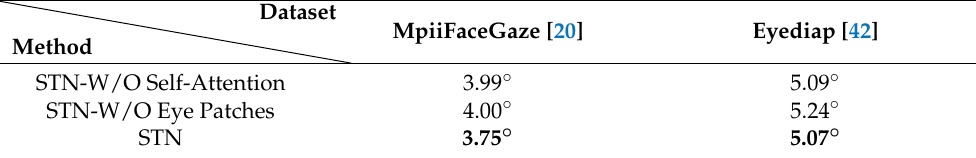
Table 2. The angular error of STN and its variants, STN-W/O Self Attention and STN-W/O Eye Patches, on MpiiFaceGaze [20] and Eyediap [42].